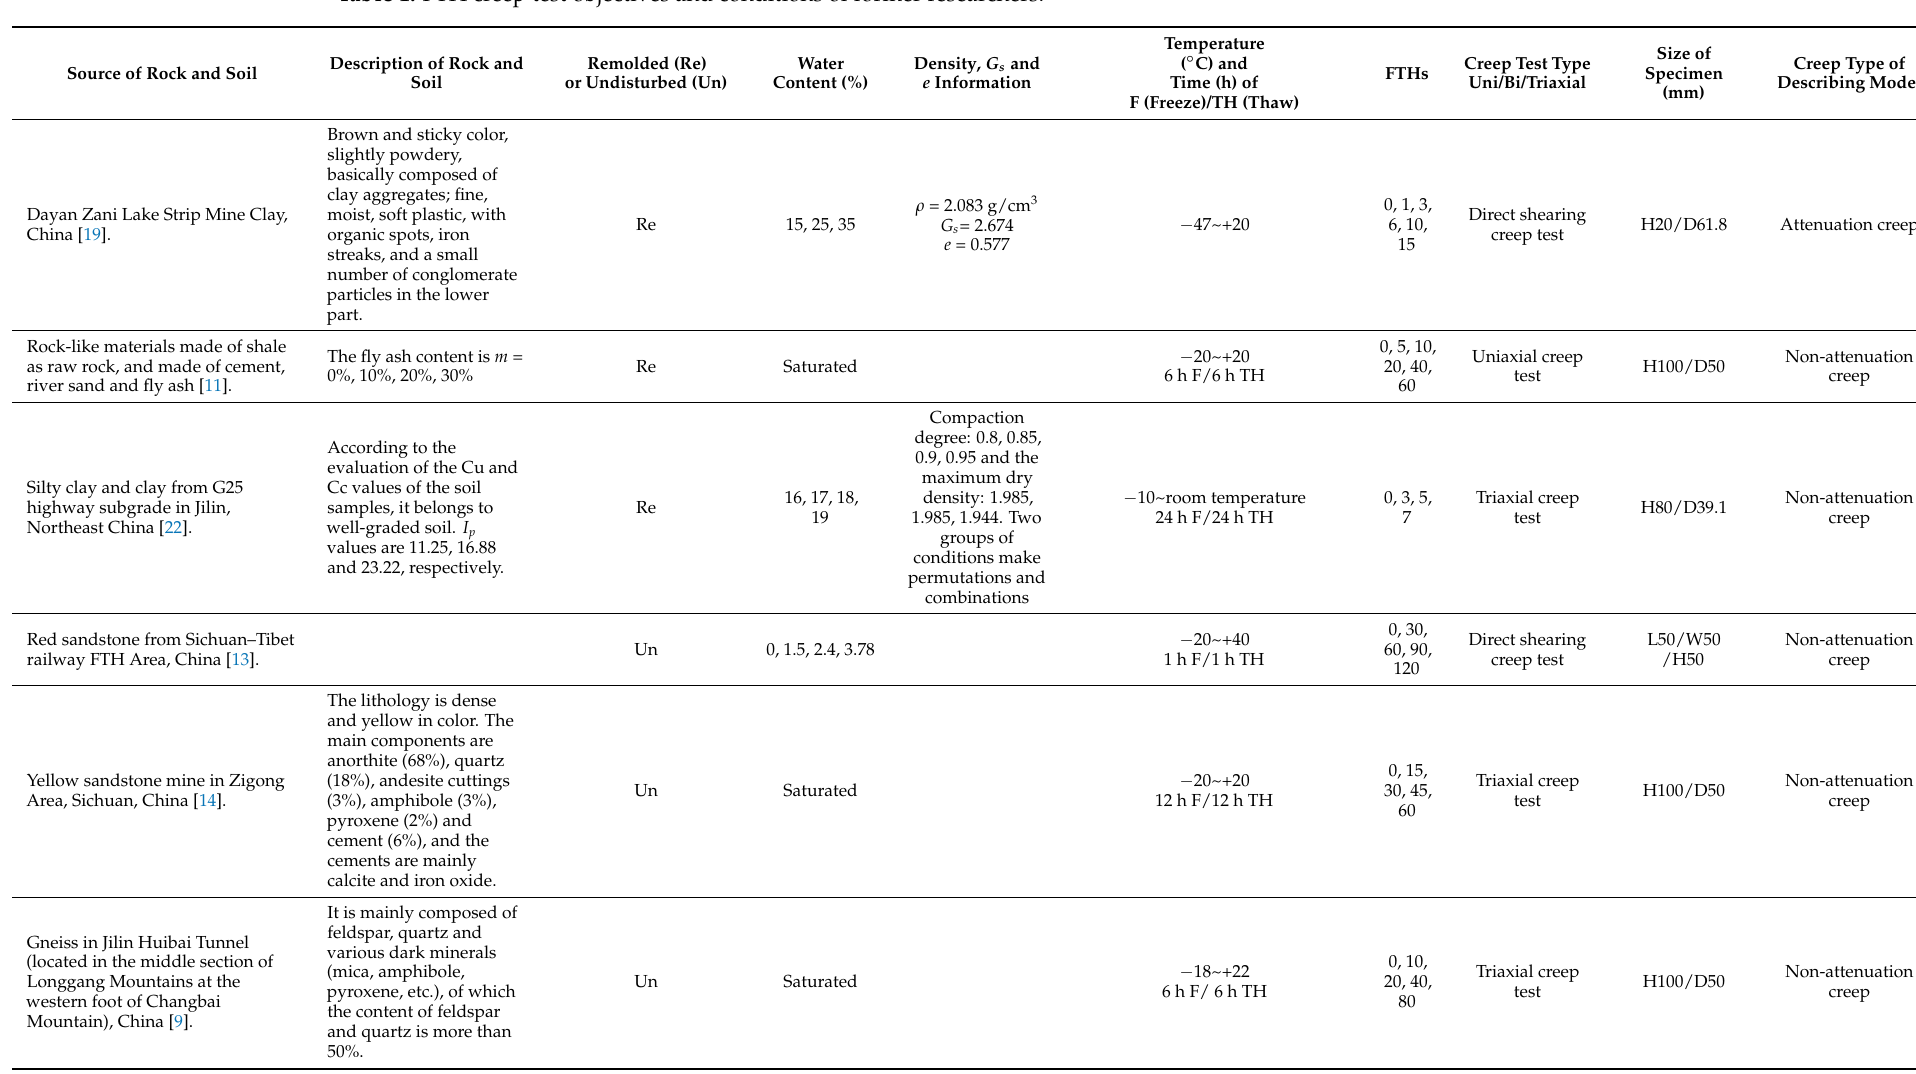
Table 1. FTH creep test objectives and conditions of former